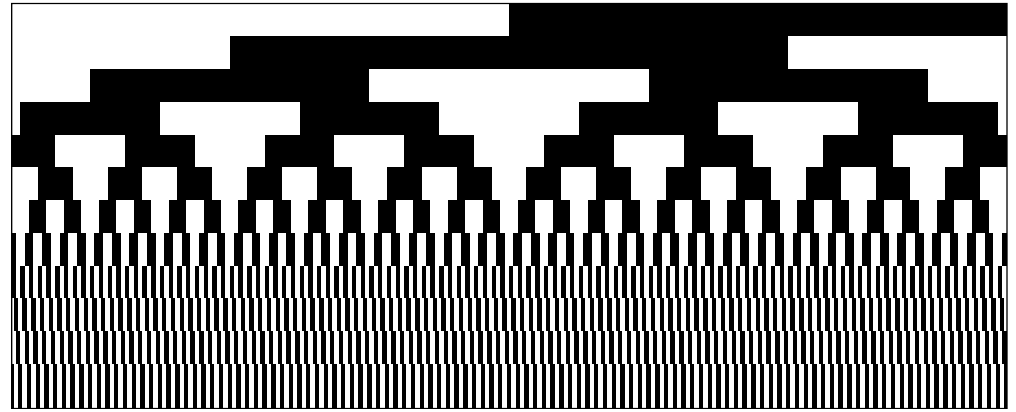
Figure 2. Coding strategy of Gray code and stripe shifting pattern. Top: Series of Gray code ( n = 8) divide region into 256 subregions. Bottom: Stripe pattern with width of 4 pixels is shifted three times to encode positions within each subregion.